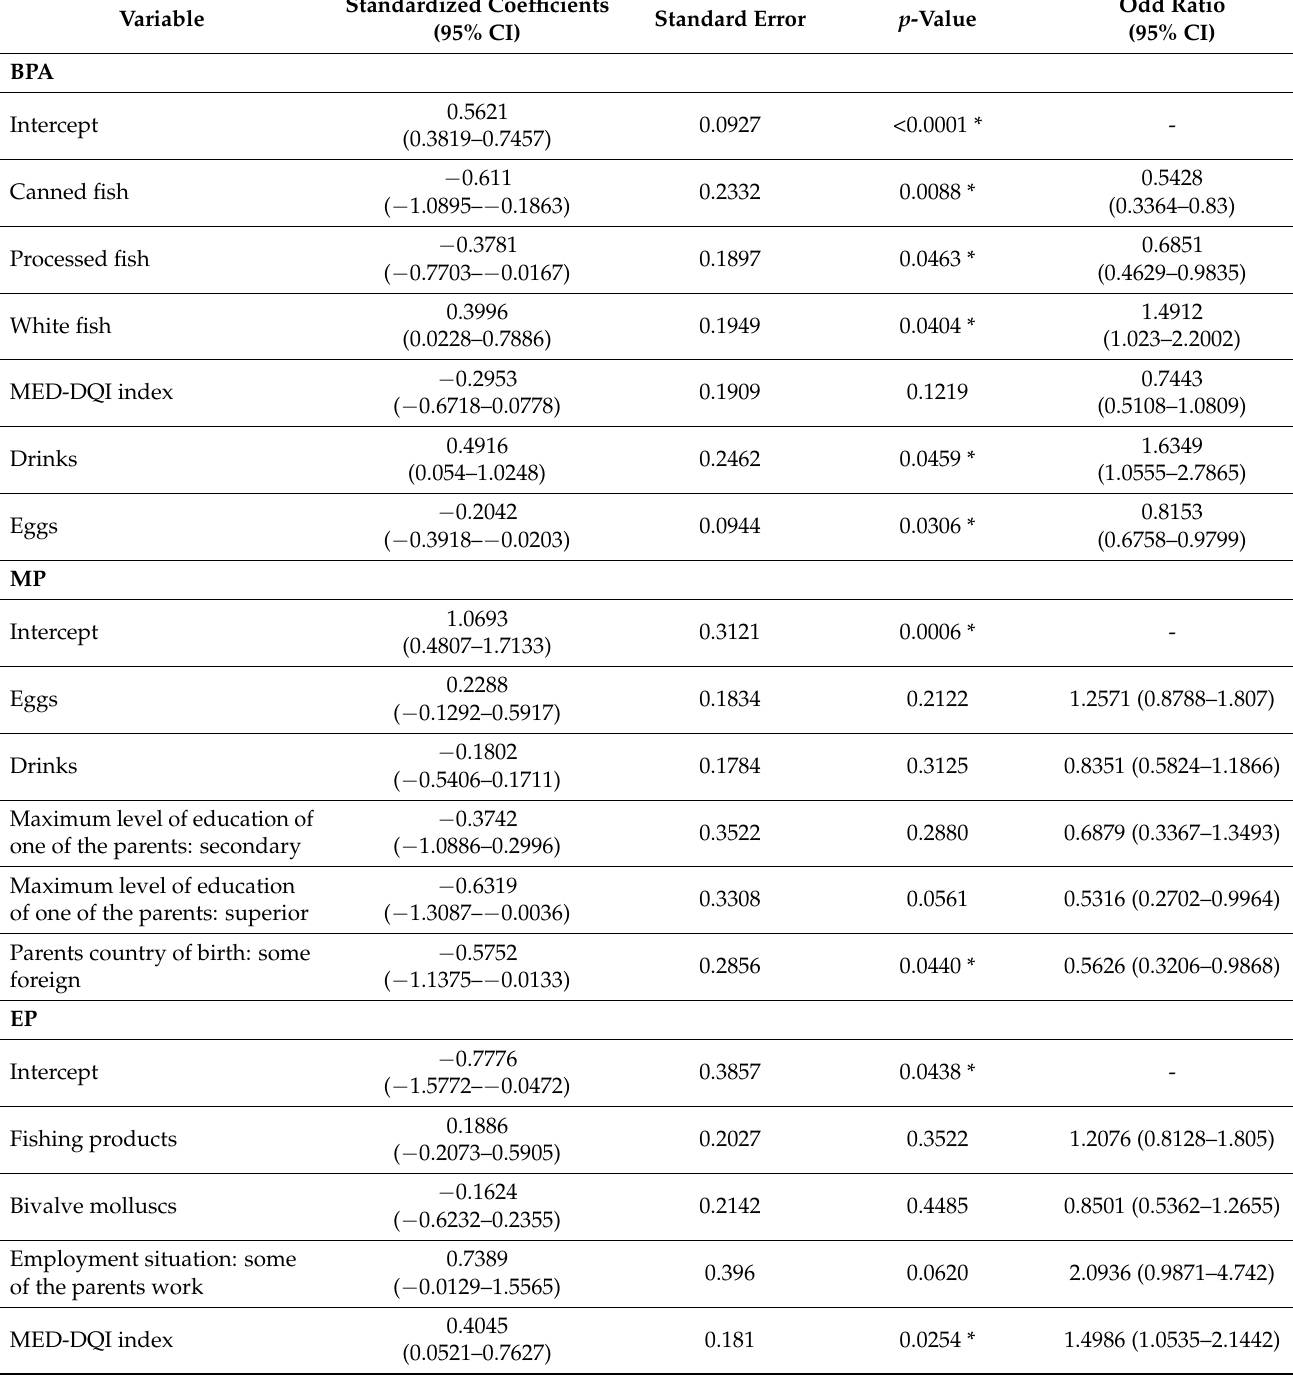
Table 3. Results of the multiple logistic regression model for presence of BPA, MP, EP and PP in urine (levels ≥